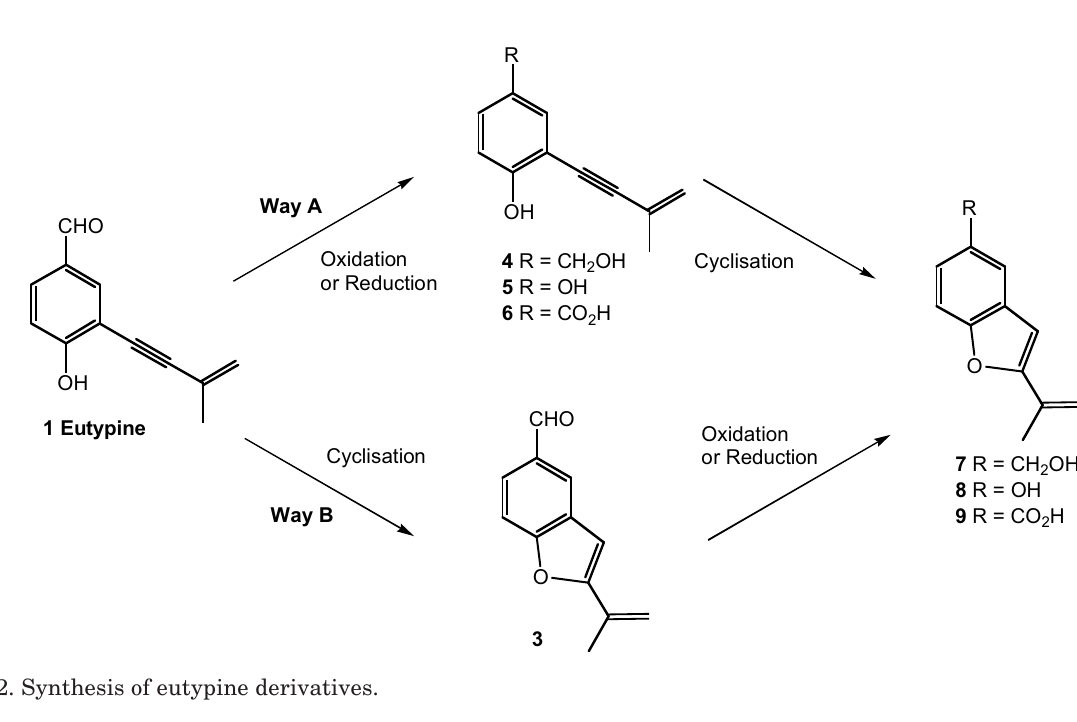
Fig. 2. Synthesis of eutypine